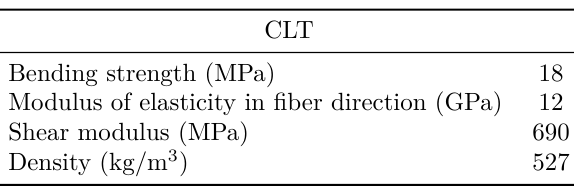
Table 1. Mechanical and physical properties of CLT [4, 5].